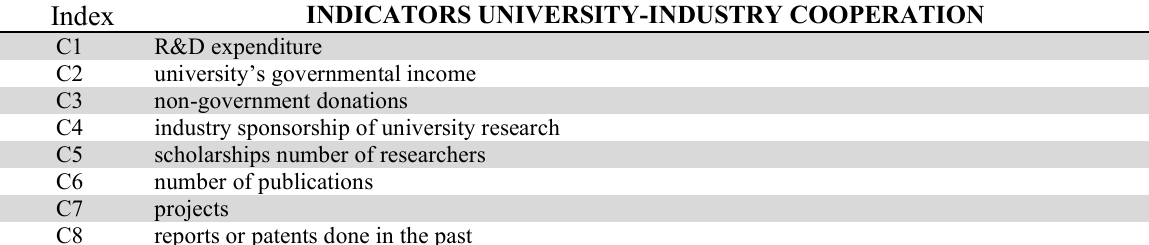
Indicators university-industry